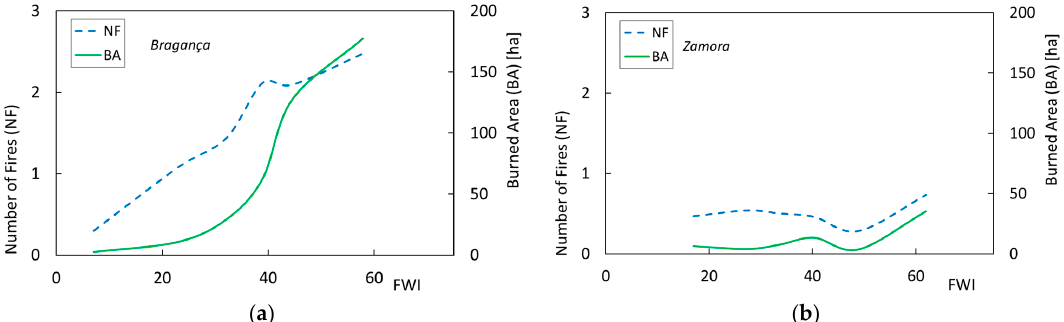
of Bragança and ( b ) the Spanish Province of Zamora.